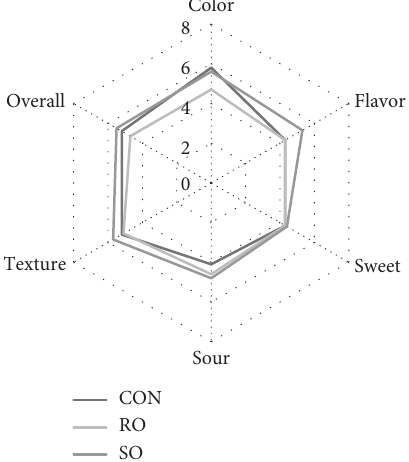
Figure 2: Sensory test results of yogurts. CON: control; RO: raw omija; SO: sugared